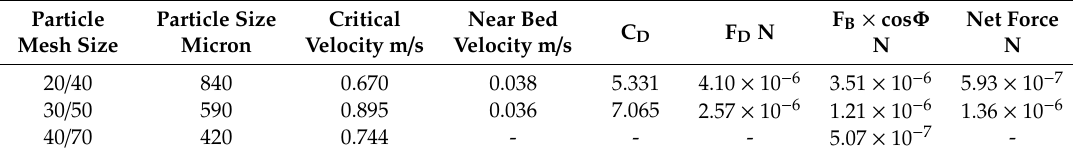
Table 4. Forces acting on a single sand particle at the critical